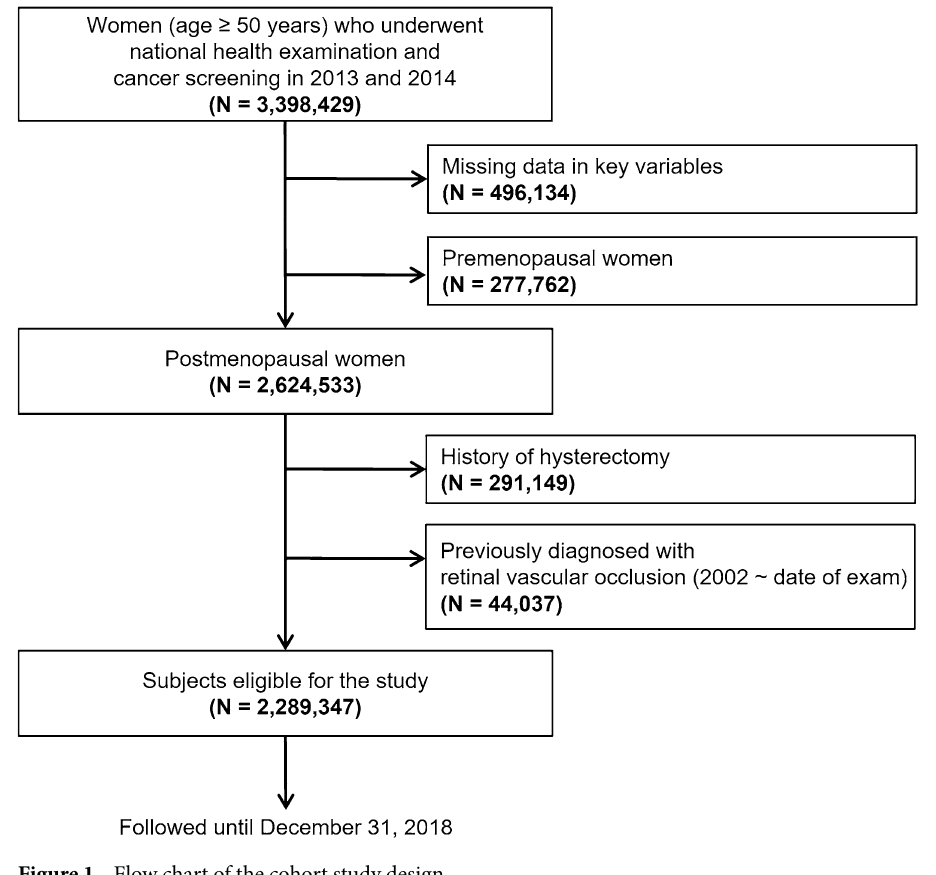
Figure 1. Flow chart of the cohort study